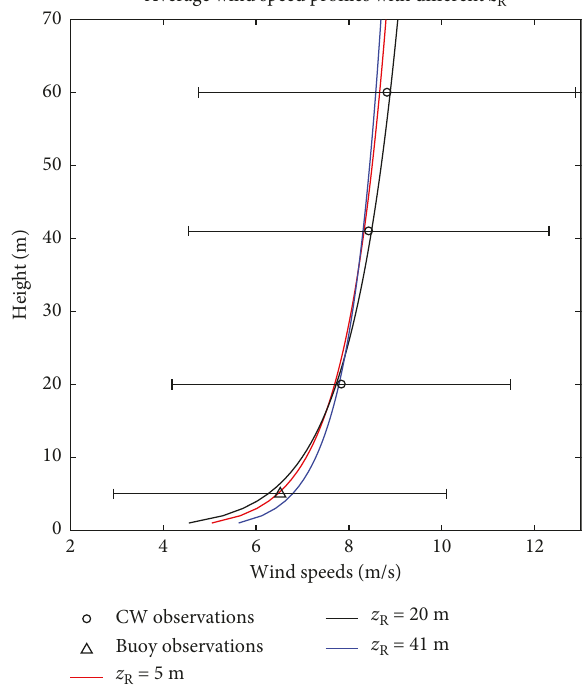
Figure 7: Average wind speed profiles obtained with z via the statistical method using 5m wind speeds from buoy 44022 and 20 and 41 m from the CW Historical campaign to predict the wind speed at 60m. Each of the three levels was tried as reference (5m in red, 20m in blue, and 41m in green), and the best per- formance was with the 20 m level as